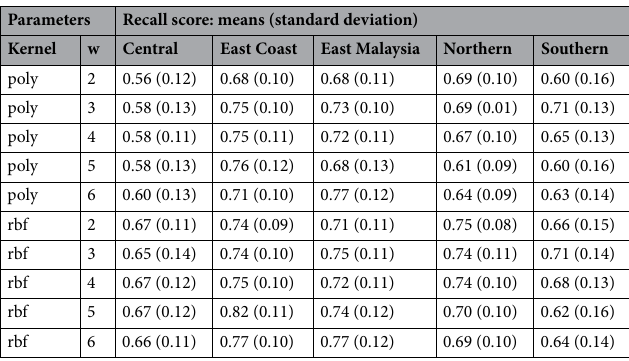
Table 8. Cross-validation result of recall score.